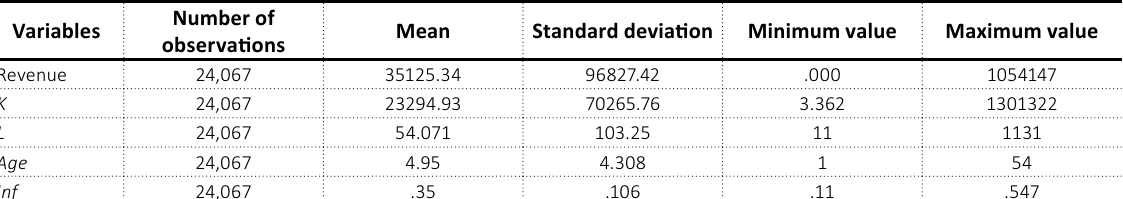
Table A1. Descriptive statistics of the data